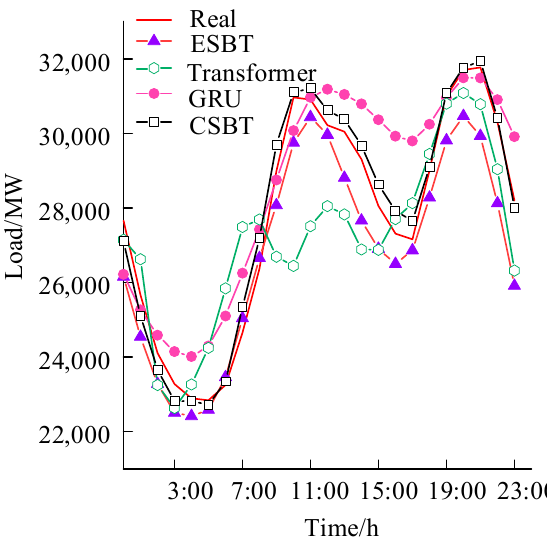
Figure 5. The forecasting results of the CBST model, Transformer, GRU, and ESBT model.